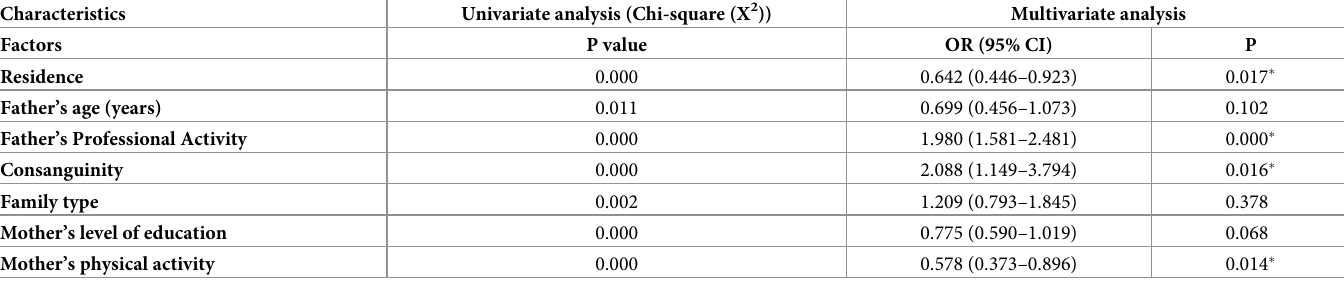
Table 3. Association between maternal and paternal socio-economic and cultural characteristics in our sample.